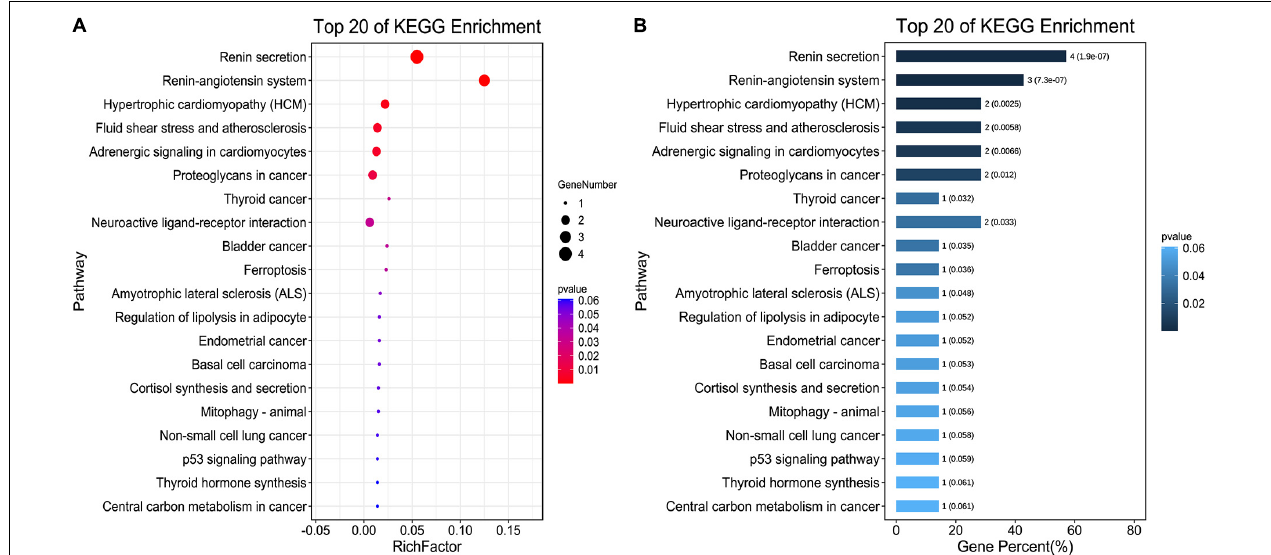
FIGURE 6 | Pathway enrichment analyses of seven target genes (ACE, CAV1, AGT, REN, ADRB2, TP53, and ALB) for the treatment of CA with SV. (A) The bubble chart shows the top 20 enriched KEGG pathways. The x -axis indicates the Enrichment Factor and the intensity of different colors indicates the adjusted p -value. (B) The histogram shows the top 20 enriched KEGG pathways. The x -axis represents the enriched Gene Percentage (%) and the intensity of different colors indicates the adjusted p -value.